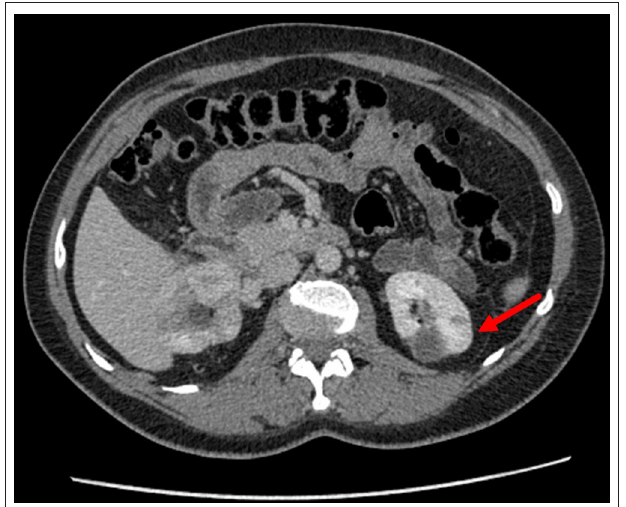
FIGURE 1 | Contrast-enhanced CT of the kidneys in patient K. The left kidney examined prior to the second surgery is indicated.